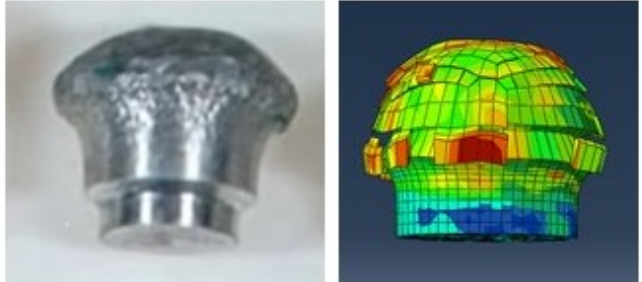
Figure 11. Visual Comparison of the Projectile with the Smoothed Particle Hydrodynamics Results.